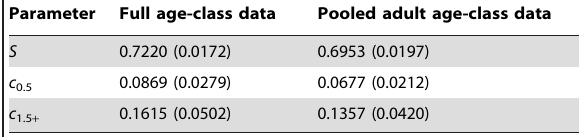
Table 2. Comparison of natural survival ( S ) and vulnerability coefficient ( c ) (SE) for reconstruction models using full age- class data and pooling of adult age-classes (2.5 +